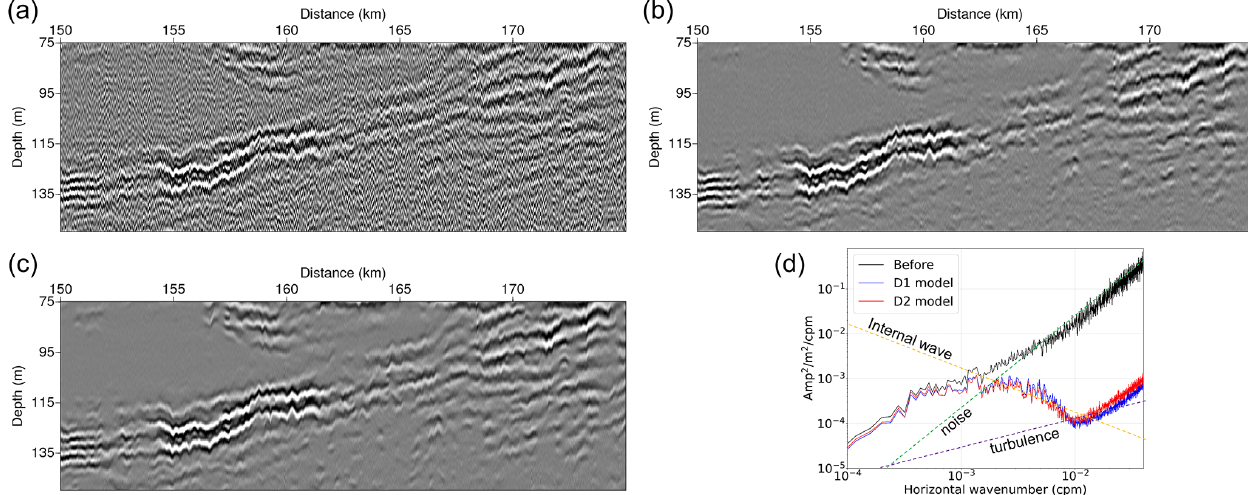
Figure 20. Extracted seismic sections (panel a shows the section before noise attenuation, b shows the section after applying the D1 model, and c shows the section after applying the D2 model). Panel (d) shows the calculated data slope spectra of (a–c)